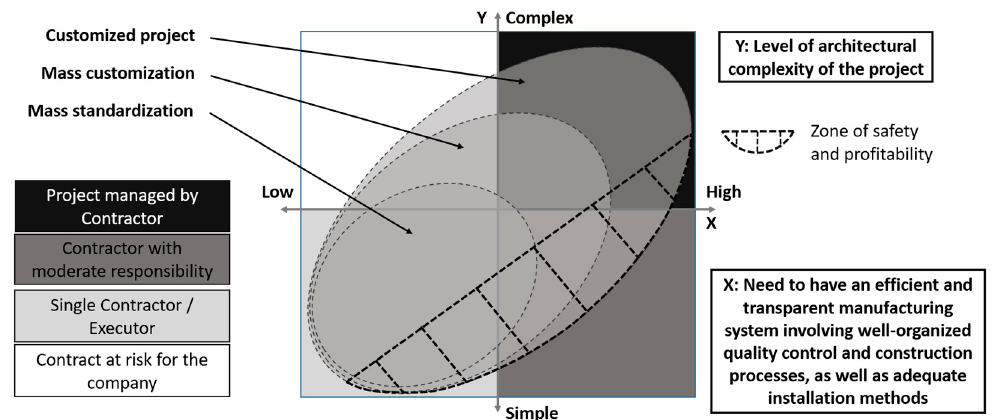
Figure 6. Conceptual 4-quadrant graph—exported project profitability analysis tool.